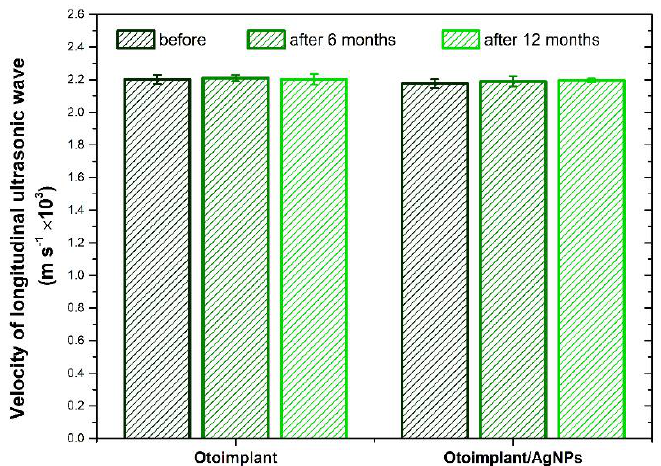
Figure 4. Velocity of longitudinal ultrasonic wave for the Otoimplant and Otoimplant/AgNPs before and after 3-, 6-, and 12-month incubation in deionized water. No statistically significant differences ( p < 0.05) were detected.